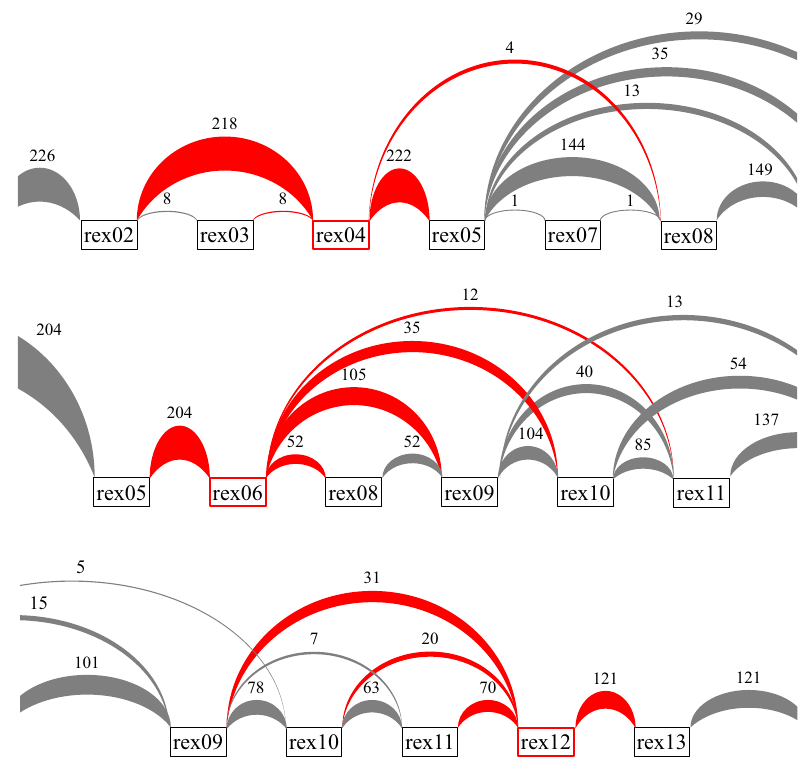
Figure 3. Frequencies of exon–exon junctions of the three novel exons. Black boxes, known exons; red boxes, novel exons. The connections between exons are depicted as arches; frequencies are shown by arch width and